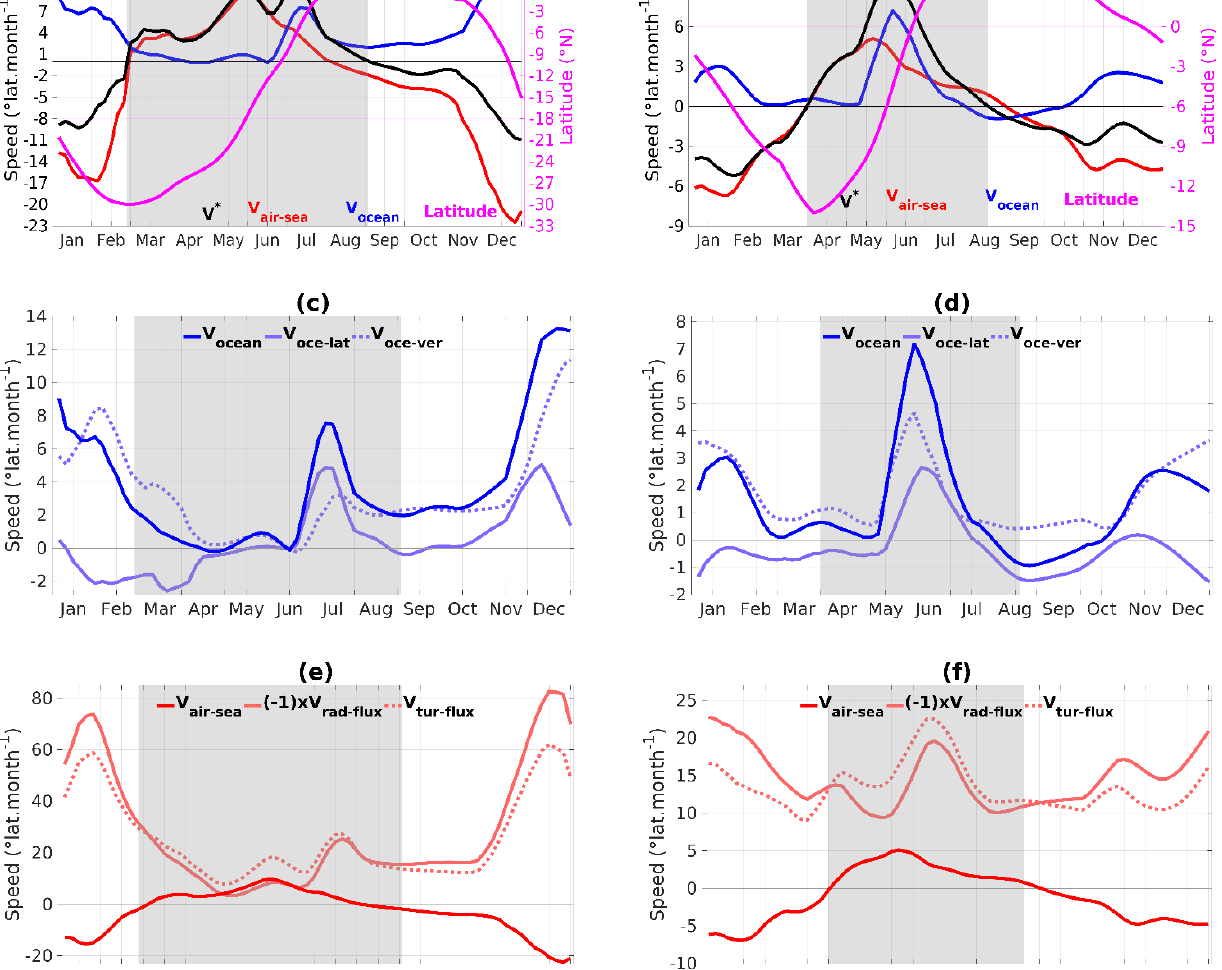
Figure 6. Same as Figure 5, but for the AWP southern boundary (SB). For a better comparison, the V rad - flux is multiplying by ( −